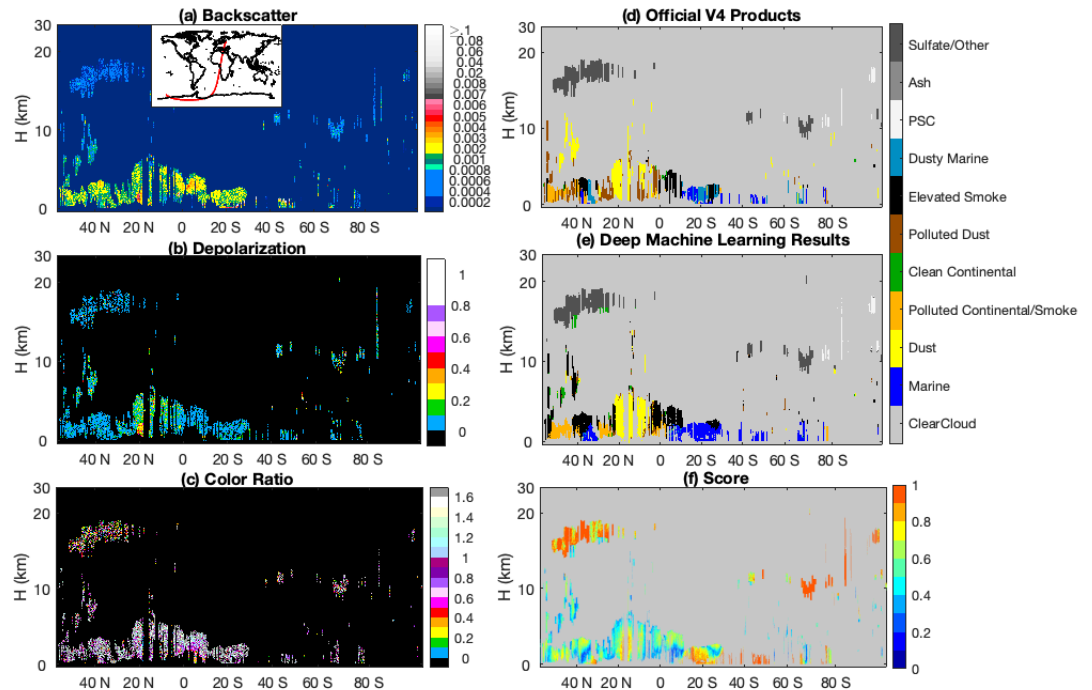
Figure 7. The information shown above is the same as in Figure 3 except for nighttime data acquired on 14 July 2011, starting from 00:42:02 UTC. ( a – c ) The 532 nm backscatter intensity, volume depolarization, and attenuated total backscatter color ratio measurements, respectively. The CALIPSO ground track is overlaid in the upper-left corner of panel ( a ). ( d ) The aerosol classifications reported by the CALIOP operational scene classification algorithms. ( e ) The classifications determined by the trained convolutional neural network. ( f ) The CNN classification scores.